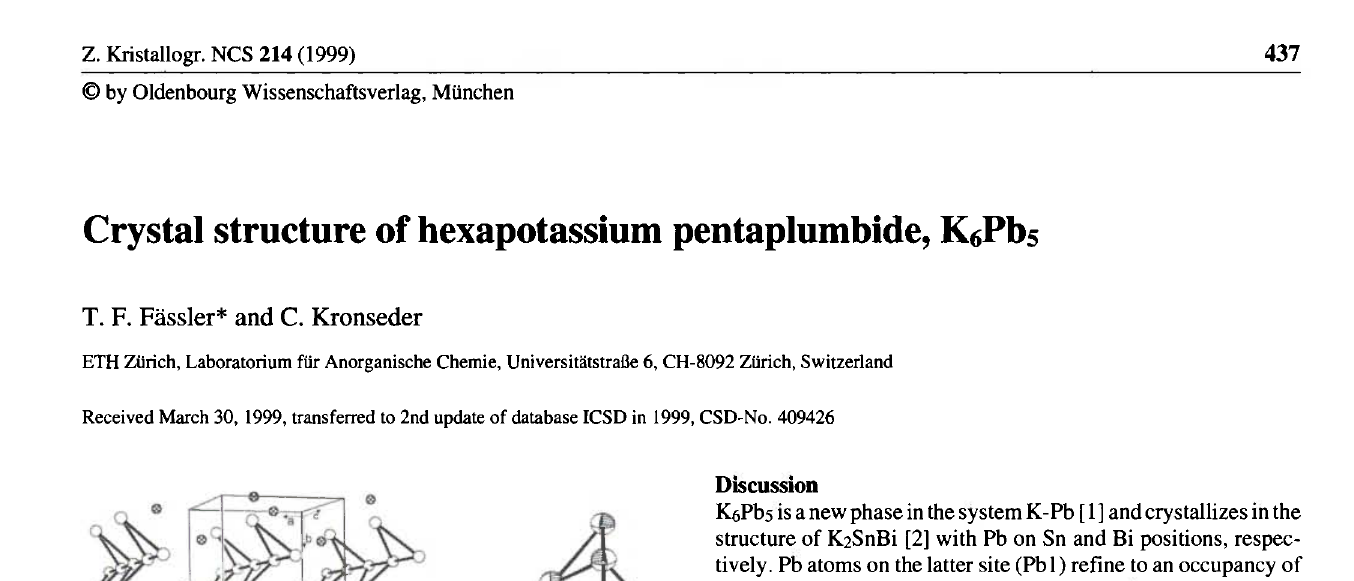
Discussion KePbs is a new phase in the system K-Pb [ 1 ] and crystallizes in the structure of foSnBi [2] with Pb on Sn and Bi positions, respec- tively. Pb atoms on the latter site (Pbl) refine to an occupancy of 0.62. During final refinement cycles the occupancy was fixed to 2/3 resulting in the composition KöPbs. There are no indications for superstructure reflections. In the crystal structure of KöPbs the The atoms are bridged with Pbl. The Pbl-Pb2 distance is